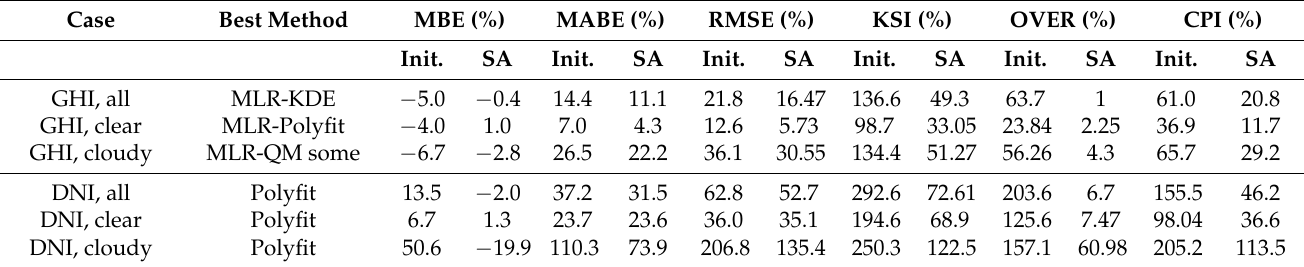
Table 4. Best ranked method for each solar irradiance component and sky